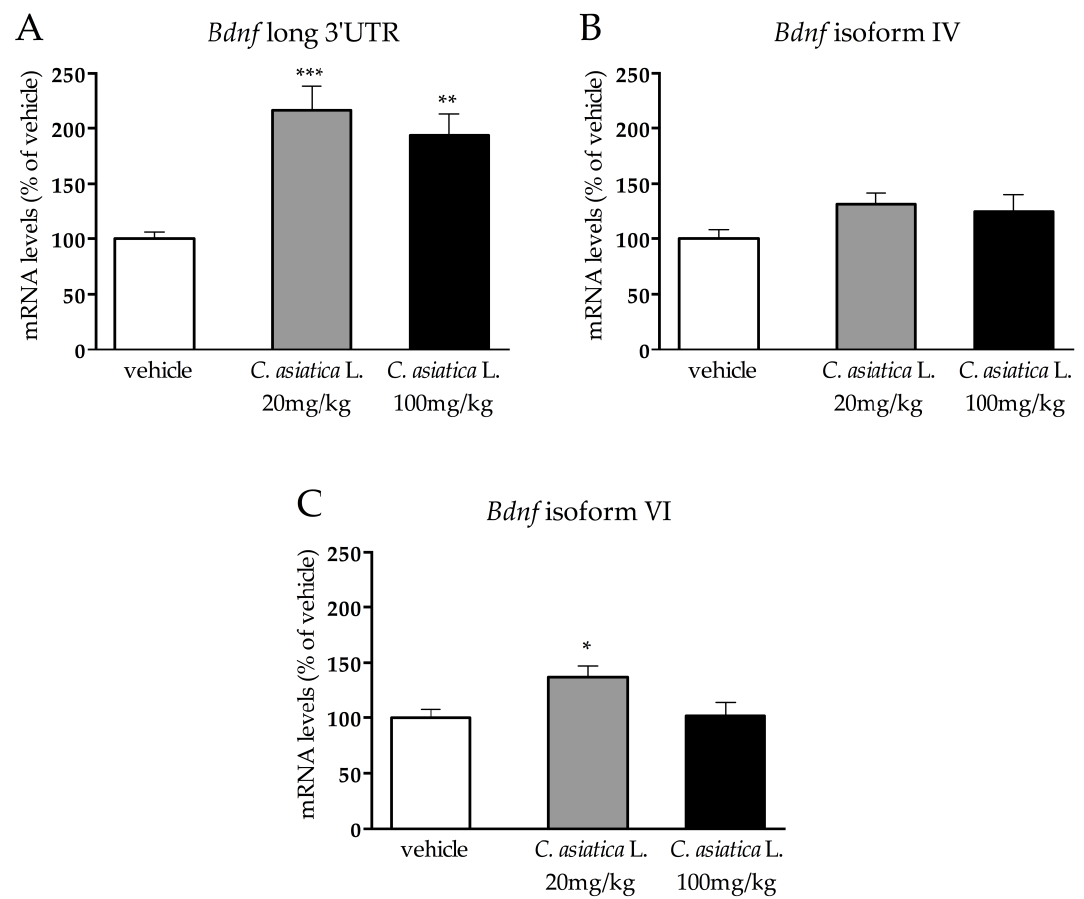
Figure 3. Analysis of Bdnf long 3′ UTR ( A ), Bdnf isoform IV ( B ), and Bdnf isoform VI ( C ) mRNA levels in the prefrontal cortex of rats that were chronically treated with 20 or 100 mg/kg of C. asiatica L. The data are expressed as a percentage of the vehicle (set at 100%) and are represented as mean SEM of at least five independent determinations. * p < 0.05; ** p < 0.01; *** p < 0.001 vs vehicle (one-way ANOVA with Fisher’s PLSD).